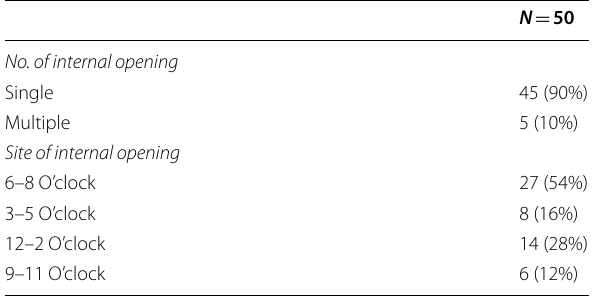
Table 6 Number and site of internal opening among